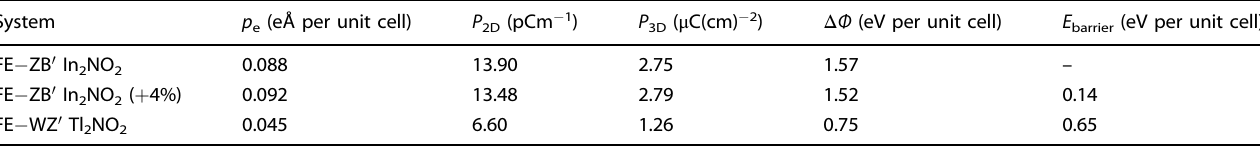
point of fcc phase (Fig. 1a), which commonly induces a symmetry- lowering phase transition according to the soft mode theory 12 . From the electrostatic potential along the z -direction (Fig. 3a), one can fi nd a vacuum level difference ( Δ Φ ) of 0.75 eV (Table 1) between the top and bottom surfaces, which indicates the existence of the intrinsic out-of-plane dipole moment. The calculated out-of-plane electric dipole moment ( p e ) using the method suggested by Ding et al. 32 is about 0.045 eÅ (Table 1), which corresponds to an out-of-plane spontaneous polarization of 6.6 pC m − 1 in the 2D unit ( P 2D ) or 1.3 μ C(cm) − 2 in the 3D unit ( P 3D ) (if the thickness is taken to be 5.2 Å). This value has the same order of magnitude as that of α -In 2 Se 332 and is larger than those of some 2D materials with out-of-plane FE, such as d 1T MoS 2 (0.18 μ C